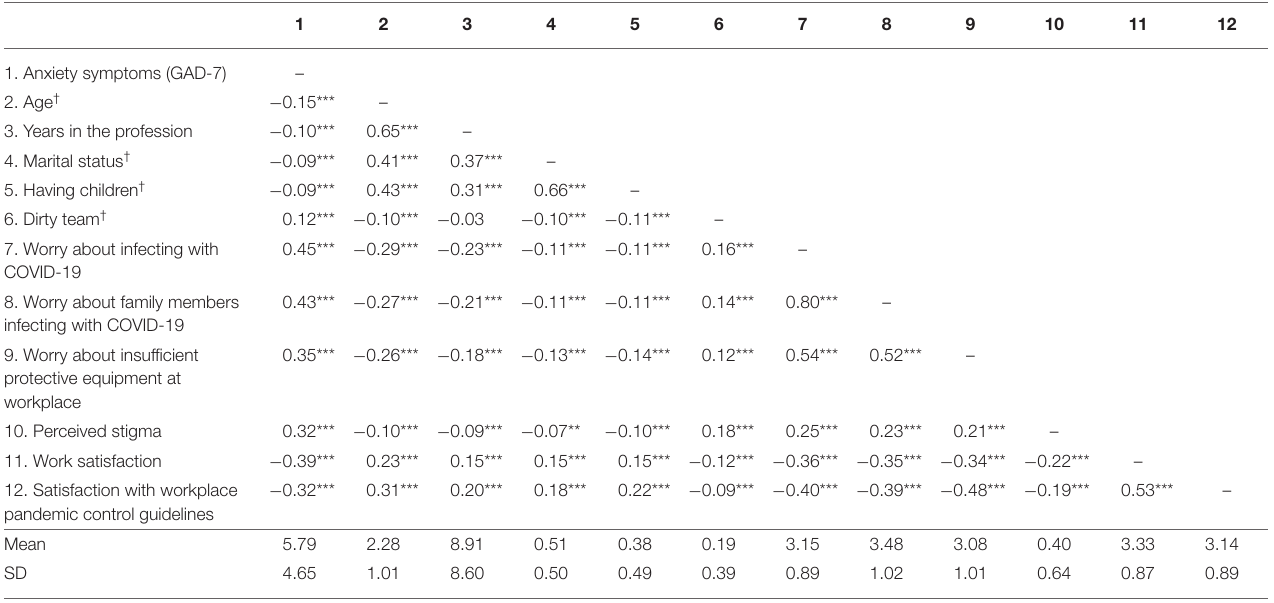
TABLE 2 | Descriptive statistics and correlations among major variables ( N = 1,510).